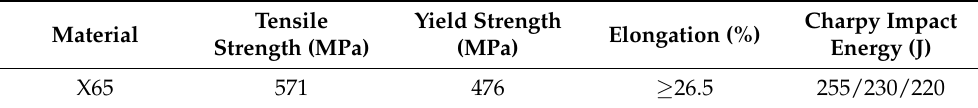
Table 2. The mechanical properties of